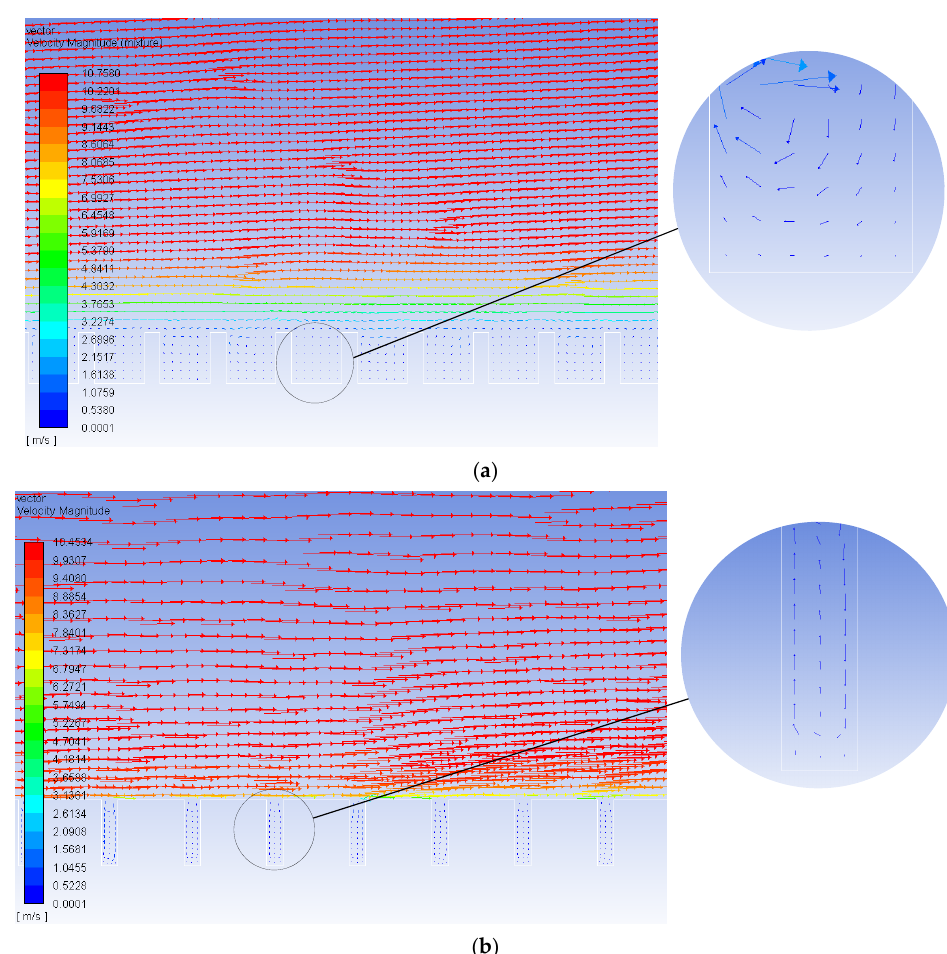
Figure 6. The velocity distribution of groove under different apparent contact angles (VOF model, 250,000 steps in FLUENT). ( a ) θ r = 154°; ( b ) θ r = 84°. For the positive slip on the hydrophobic surface, the slip length was numerically equal to the vertical distance from the inner wall to the outer wall, until the point where the velocity was zero. Next, when the slip length was equal to the thickness of the viscous